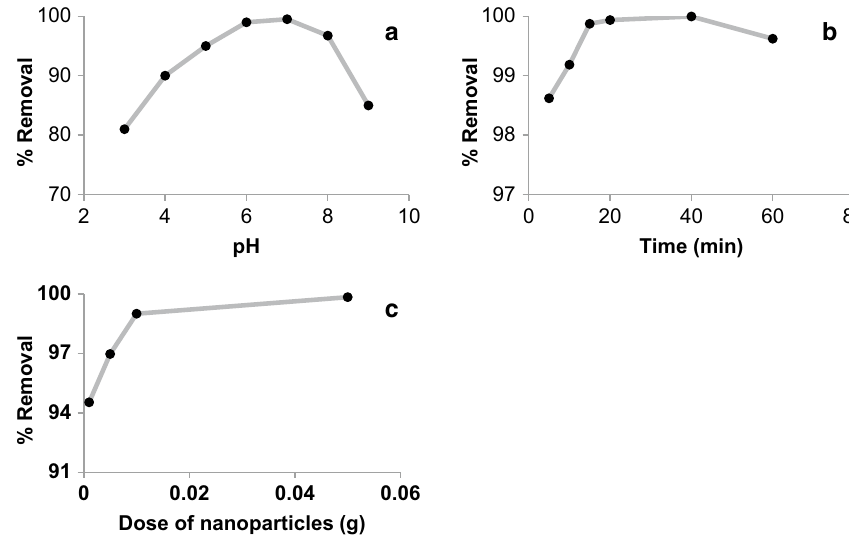
Fig. 3 The effects of a pH, b contact time and c dose of adsorbent on removal of lead ion by HA